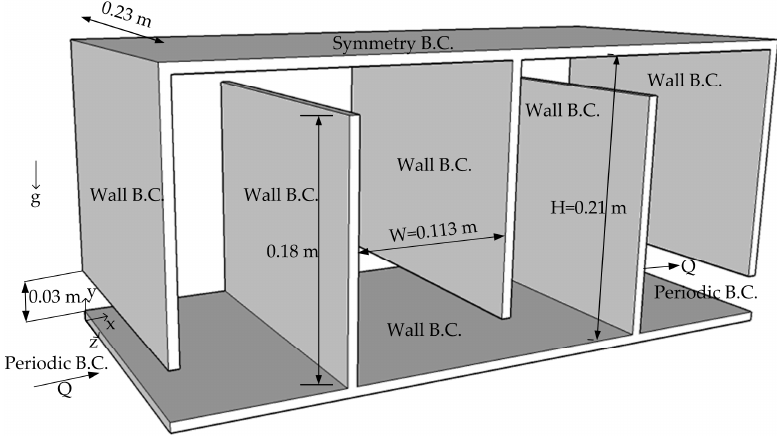
Figure 1. Three ‐ dimensional view of the computational domain and boundary conditions. Figure 1. Three-dimensional view of the computational domain and boundary